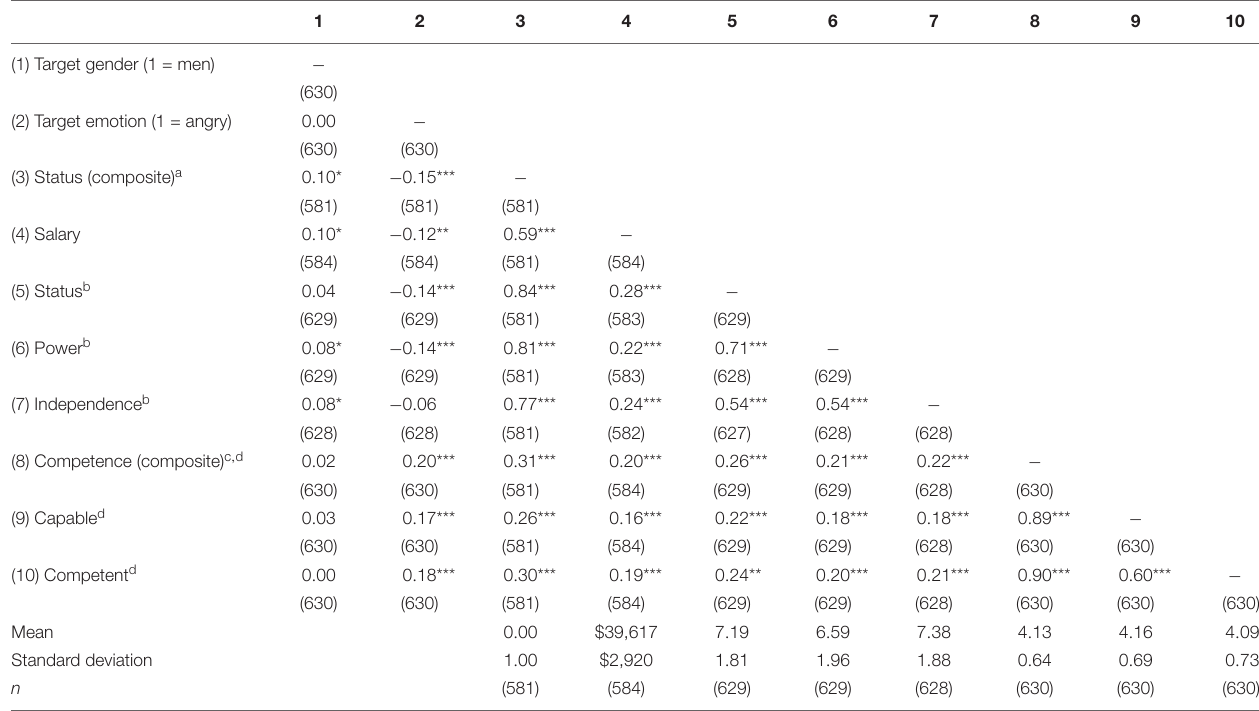
TABLE 1 | Correlations and descriptive statistics among primary study variables.